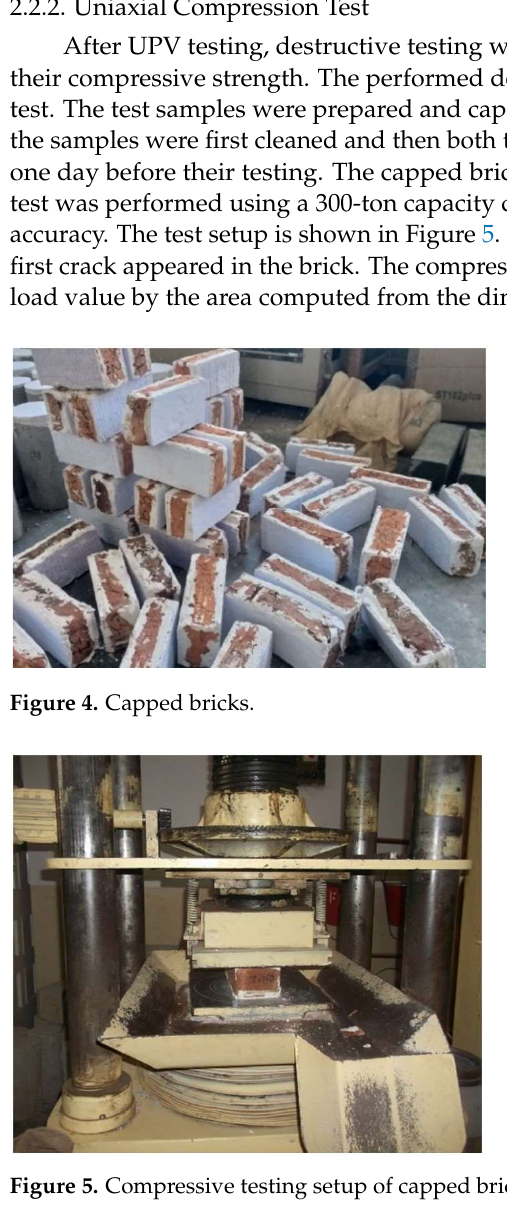
Figure 3. UPV test setup.